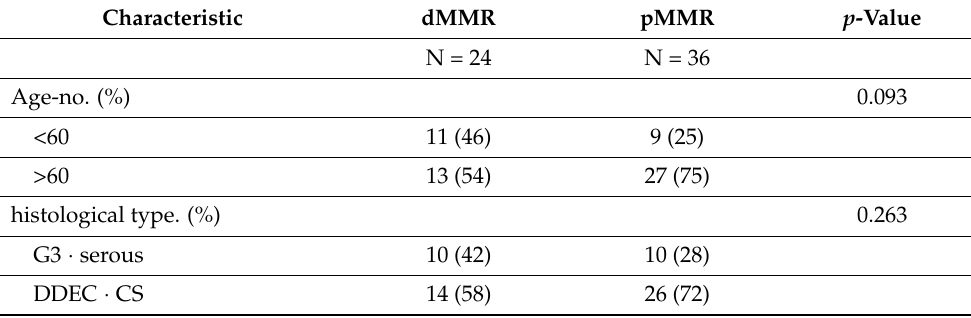
Table 1. Relationship between MMR status and clinicopathological